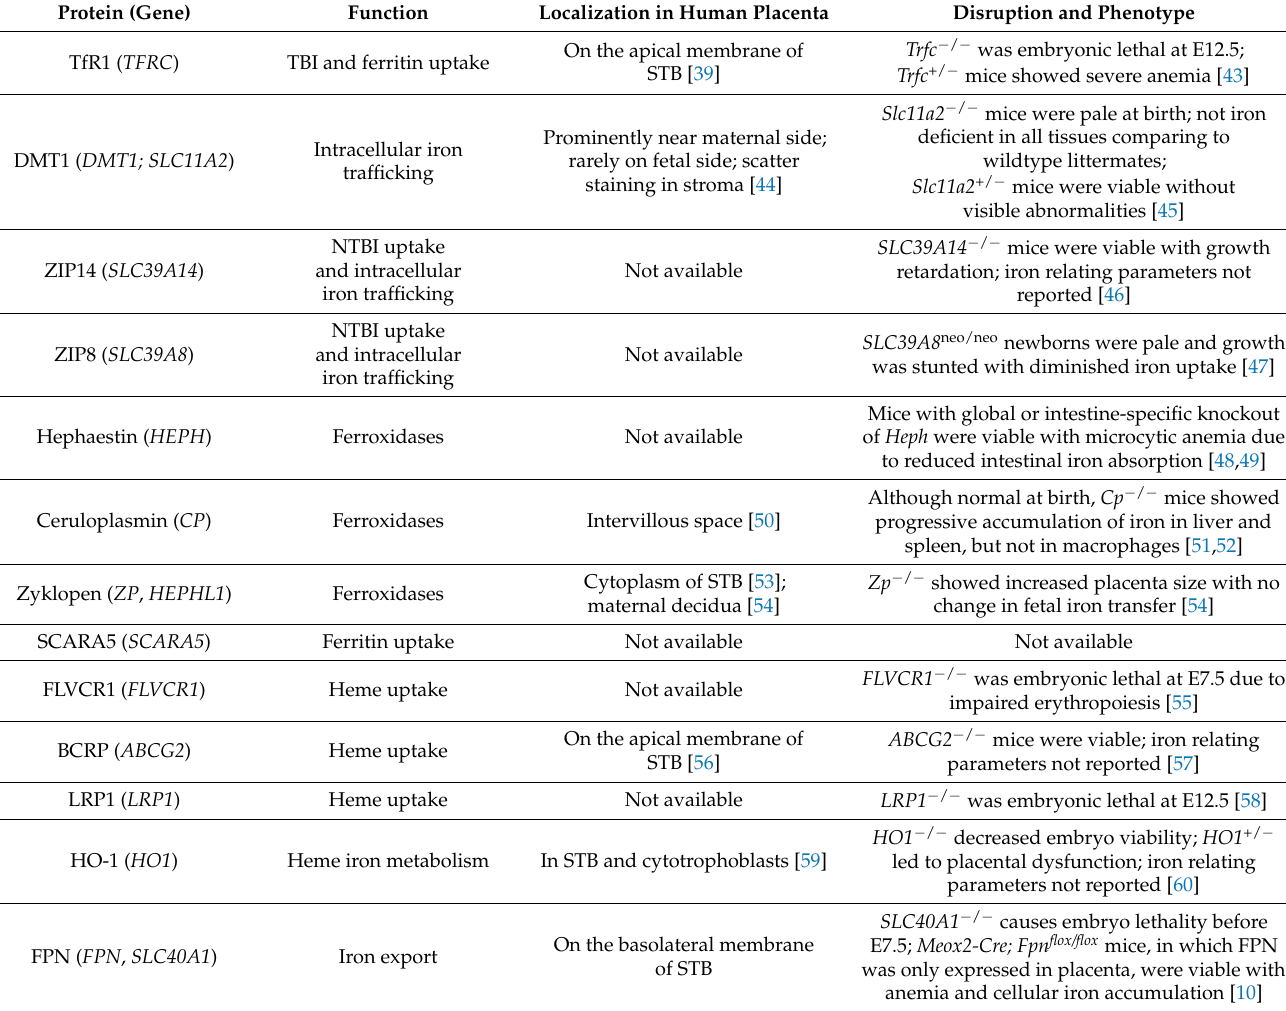
Table 1. Function and localization of iron transporters in